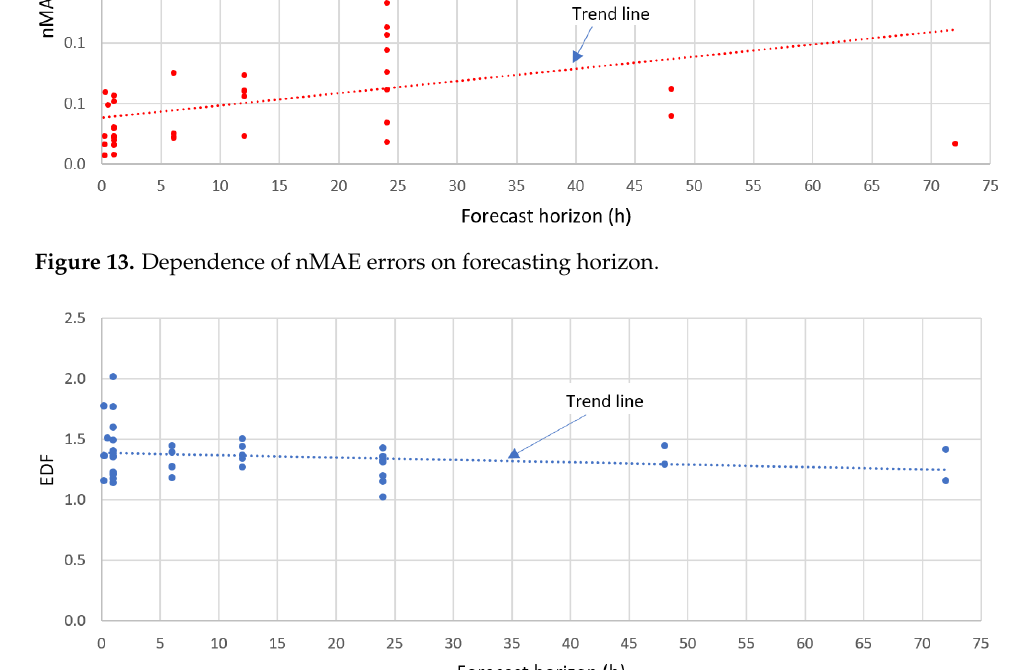
Figure 14. Dependence of EDF on forecasting horizon.